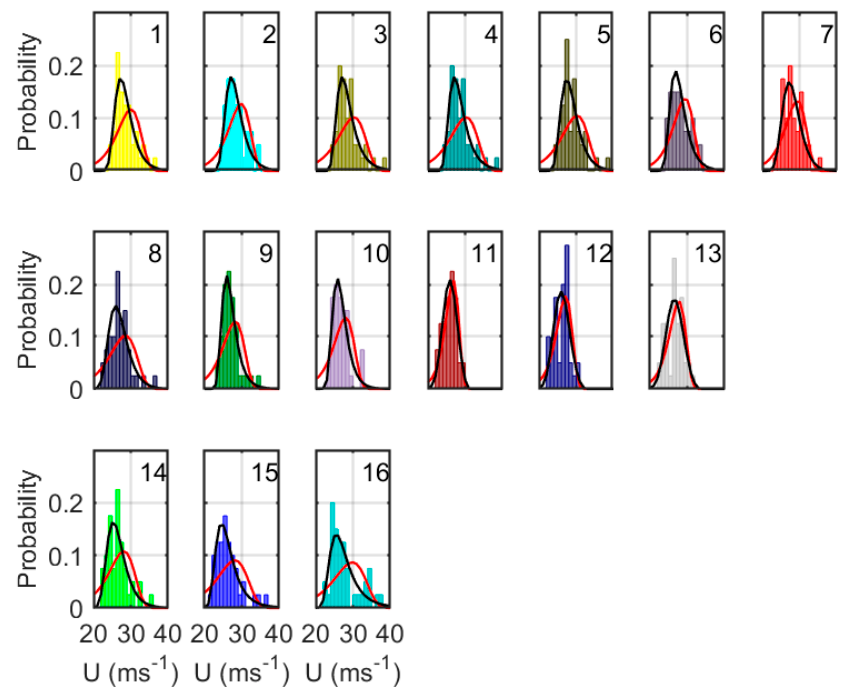
Figure 8. Histograms of the annual maximum wind speed data for each LA. The color coding is as in Figures 1 and 2. The north LA are shown in the top row, the mid LA in the central row and the south LA in the bottom row. The LA numbers are indicated in the top right of each panel. The red line indicates the fit to the Gumbel distribution from the maximum likelihood method. The black line shows the 3 parameter GEV fit (Equation (1)).